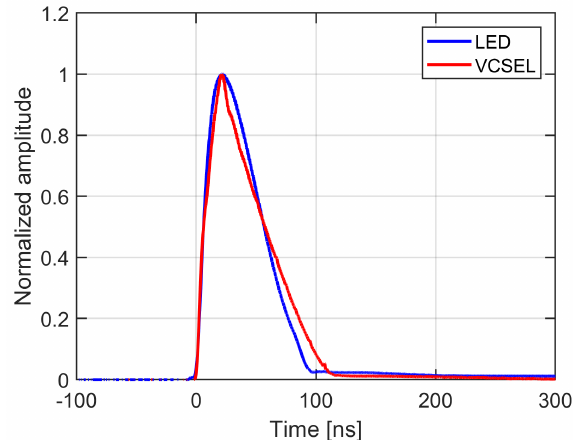
Figure 4. Measured pulse profiles for a 50 ns pulse duration with both LED and vertical-cavity surface-emitting laser (VCSEL) illumination systems developed in our